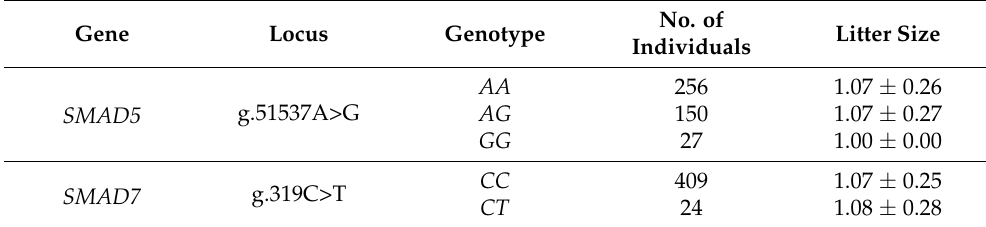
Table 4. Association analysis of single nucleotide polymorphism of SMAD5 and SMAD7 and the litter size of Tibetan